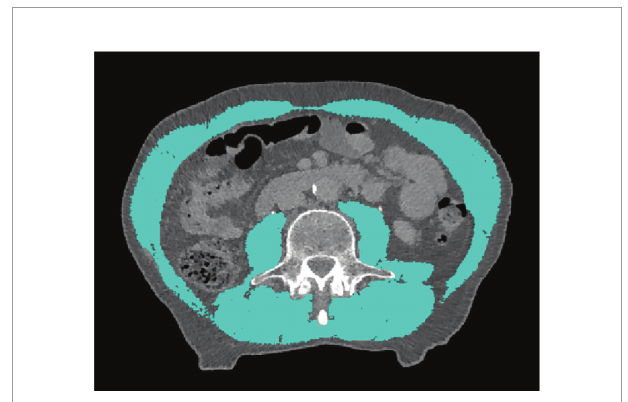
FIGURE 1 | Delineation of skeletal muscle tissue on transversal CT imaging at the level of L3. A Houns fi eld Unit window of -29 to +150 was used to accentuate skeletal muscle tissue.